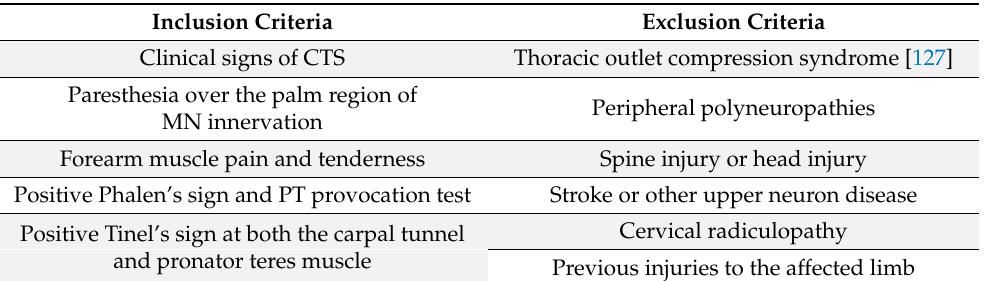
Table 5. Inclusion and exclusion criteria for the Hsiao [4] “double crush” diagnostic